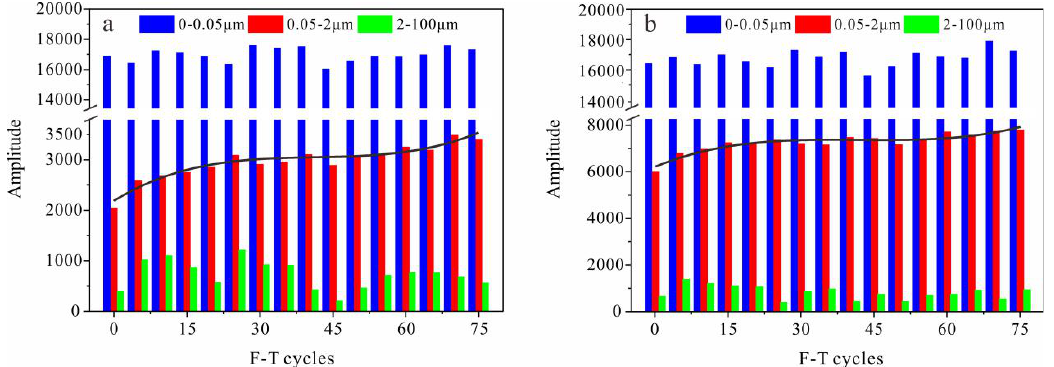
Figure 9. Changes in the total area of aperture-type T 2 spectra with F-T cycles in samples with ( a ) perpendicular bedding (S per ) and ( b ) parallel bedding (S par ).